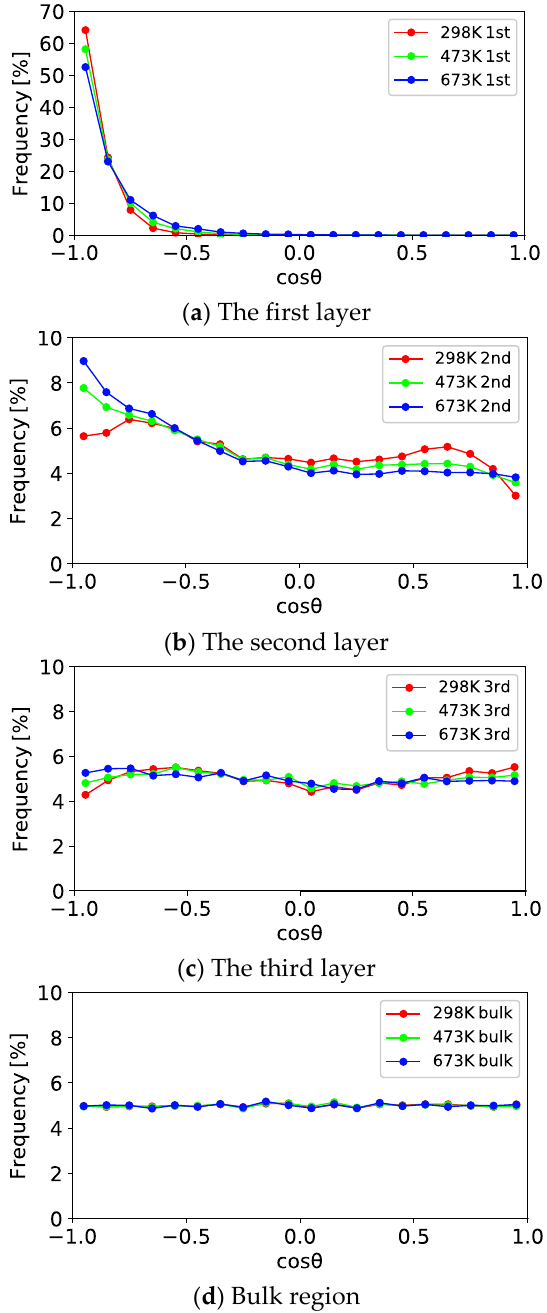
Figure 11. Distributions of cos θ at ( a ) the first layer, ( b ) the second layer, ( c ) the third layer, and ( d ) bulk region (2.0 nm < d < 3.0 nm). Each pressure condition is 50 MPa.